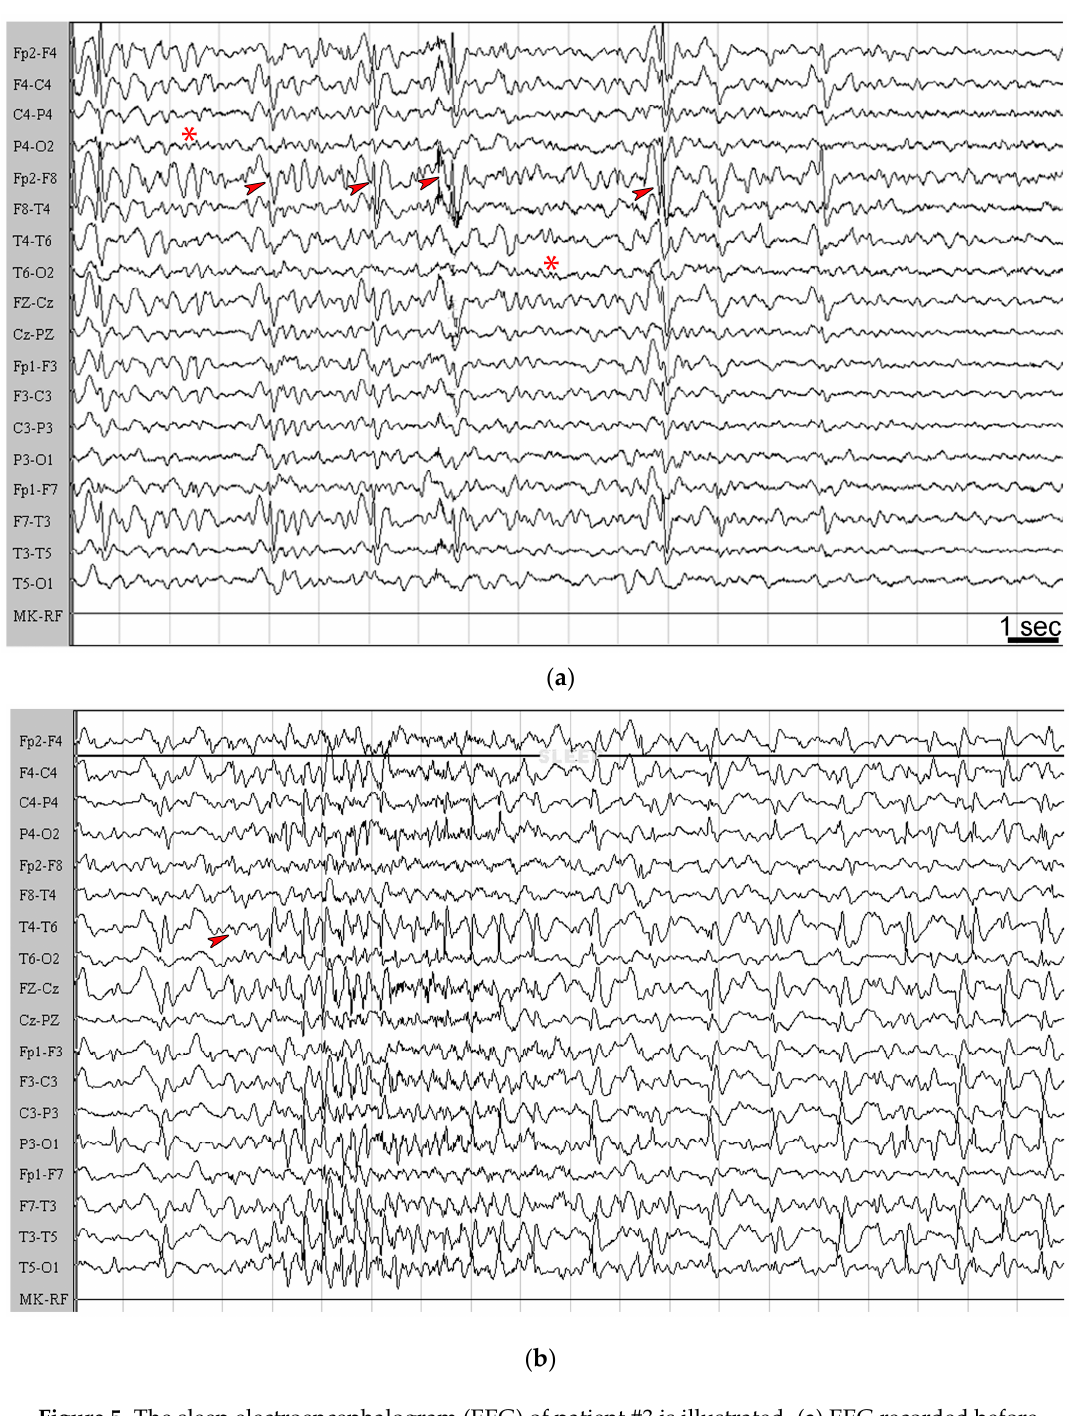
Figure 5. The sleep electroencephalogram (EEG) of patient #3 is illustrated. ( a ) EEG recorded before starting the ketogenic diet (KD). Note that a lack of spike and wave activities in the centroposterior areas is indicated by asterisks. Slow and sharp waves are frequently recorded from frontal regions (arrowheads), with a tendency to generalize and synchronize in bursts. ( b ) EEG obtained under treatment with the KD. Note that subcontinuous high-voltage sharp-waves are present (arrowhead), and that short ictal activity, which corresponded to minimal clinical expression (staring with slow rhythmic eye movements), is also detectable. EEG recordings were made by a 12 channel system (Galileo NT Suite Software). Images are presented on longitudinal reading montages. Amplitude, 20 µV/mm.